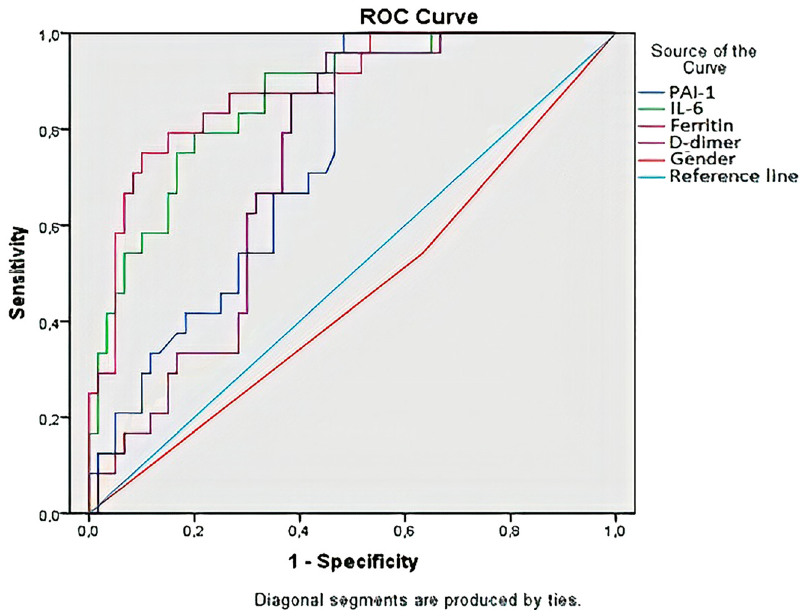
Figure 1: Evaluation of the relationship of the survival status of the patients with gender and measured parameters and the sensitivity and specificity of these values with the ROC